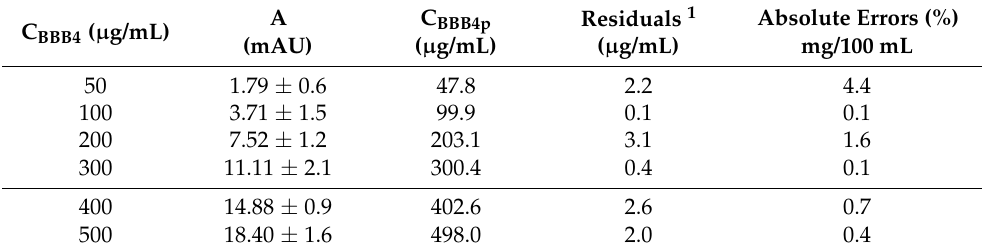
Table 2. Data of the calibration curve: absorbance (A mean ± SD), BBB4 standards